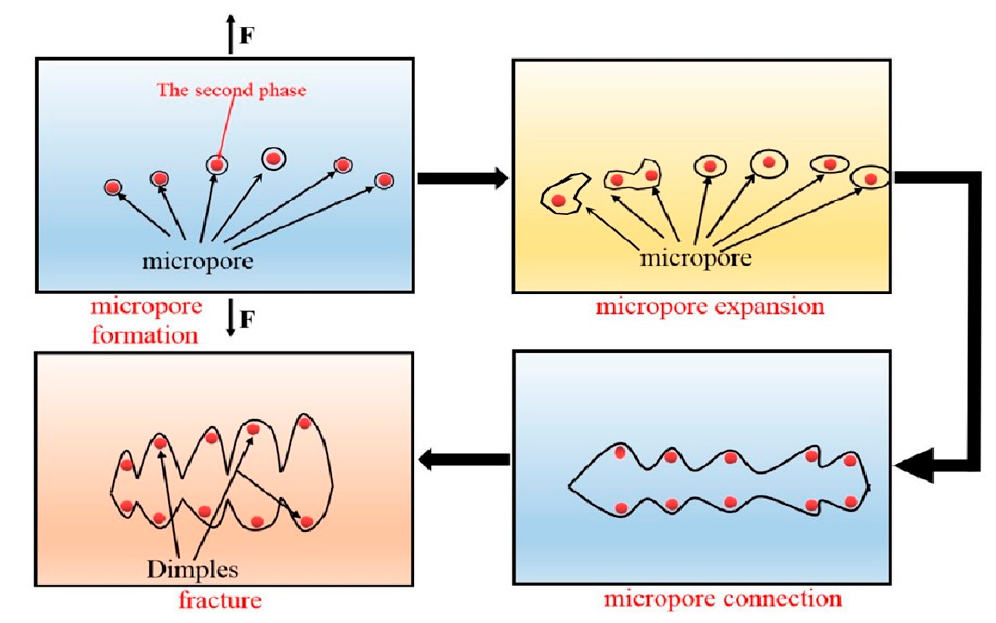
Figure 7. Schematic diagram of Figure 7 Schematic diagram of fracture.